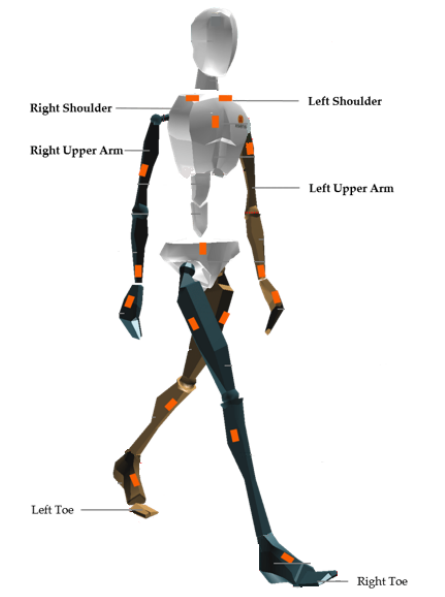
Figure 1. Xsens Avatar with indication of the six body placements in which both inertial data and ground truth 3D position are provided, extracted from [33].